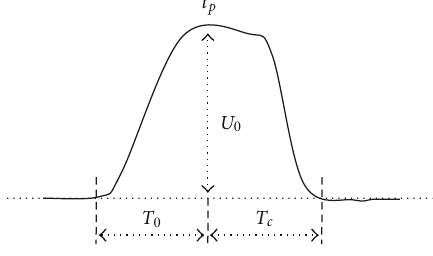
Figure 1: Glottal shape model as proposed by Fant